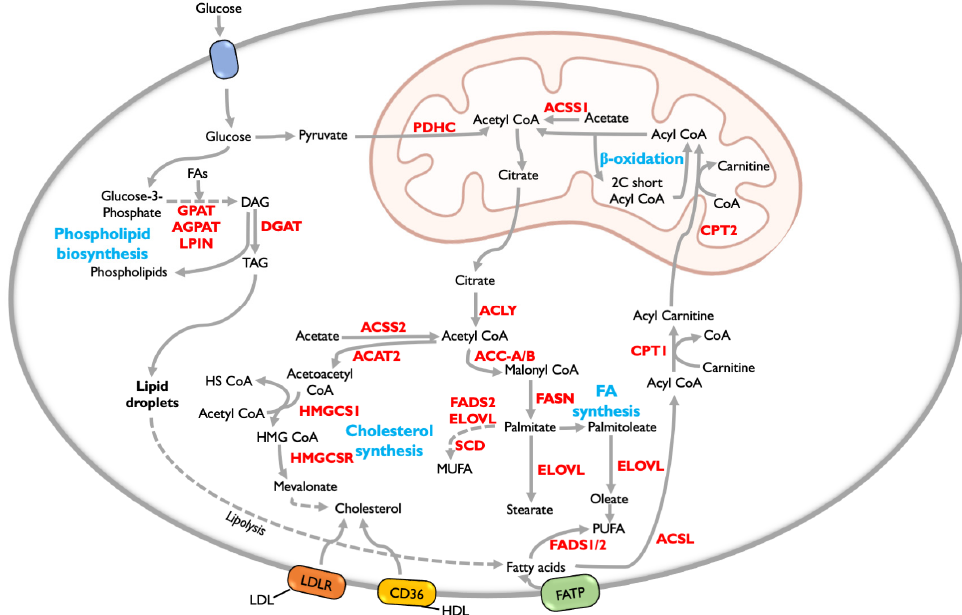
Figure 2. The fundamental biosynthetic pathways of lipid metabolism in cancer [46,77,78]. The red color indicates the important enzymes involved in lipid metabolism. The blue color indicates the